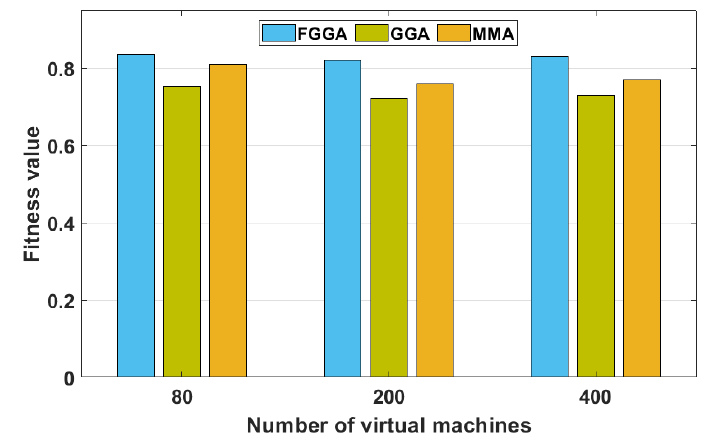
Figure 12. Comparison of fitness